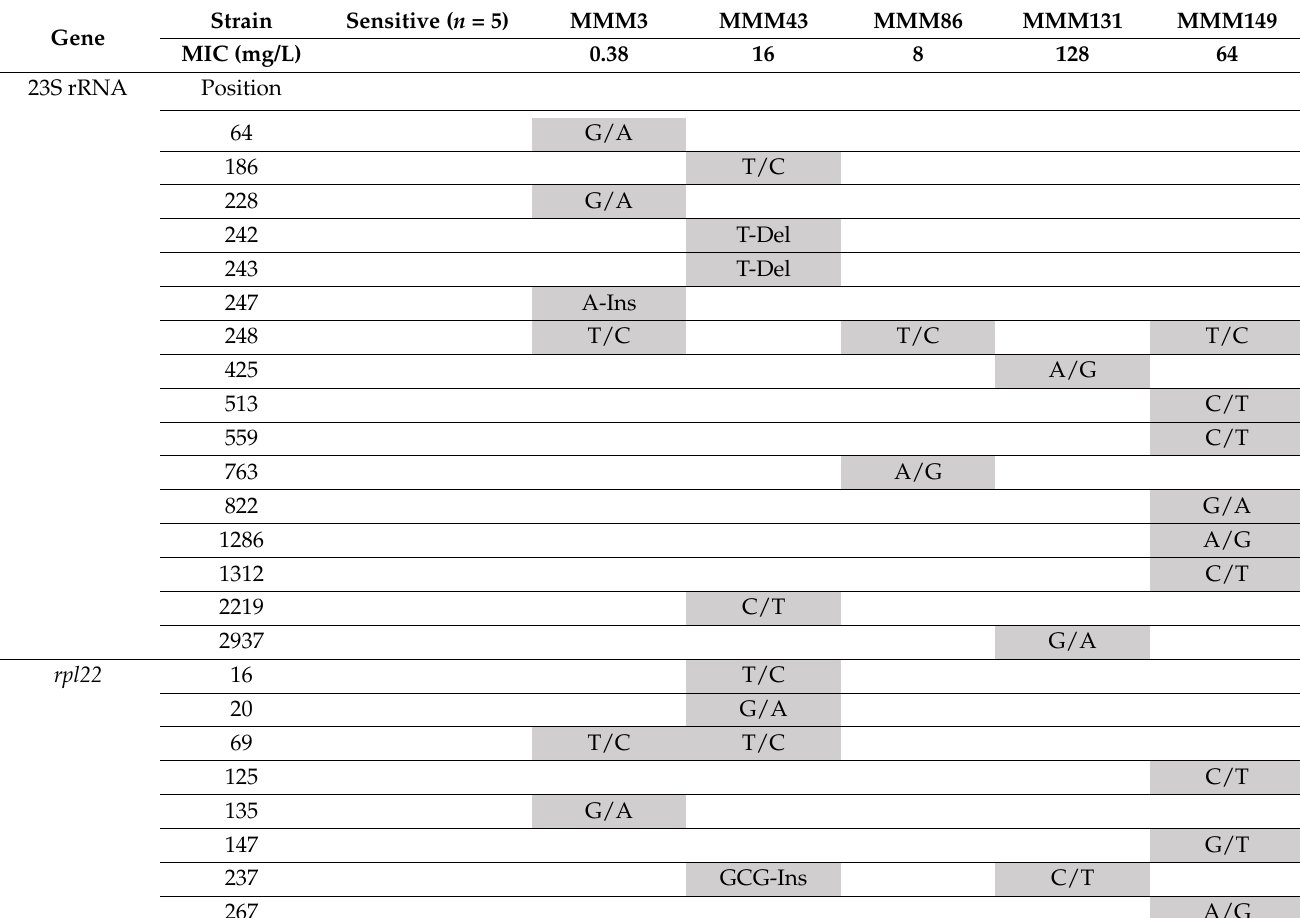
Table 4. Mutations in 23S rRNA and rpl22 that were associated with